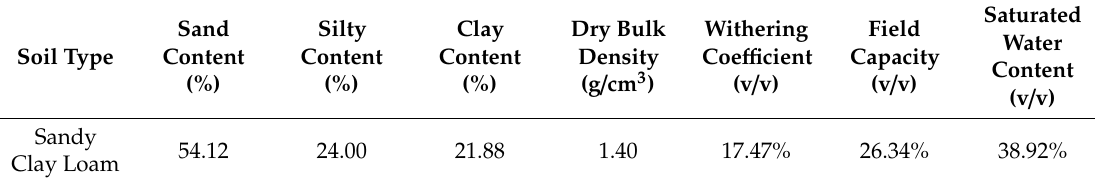
Table 2. Soil characteristics parameters.